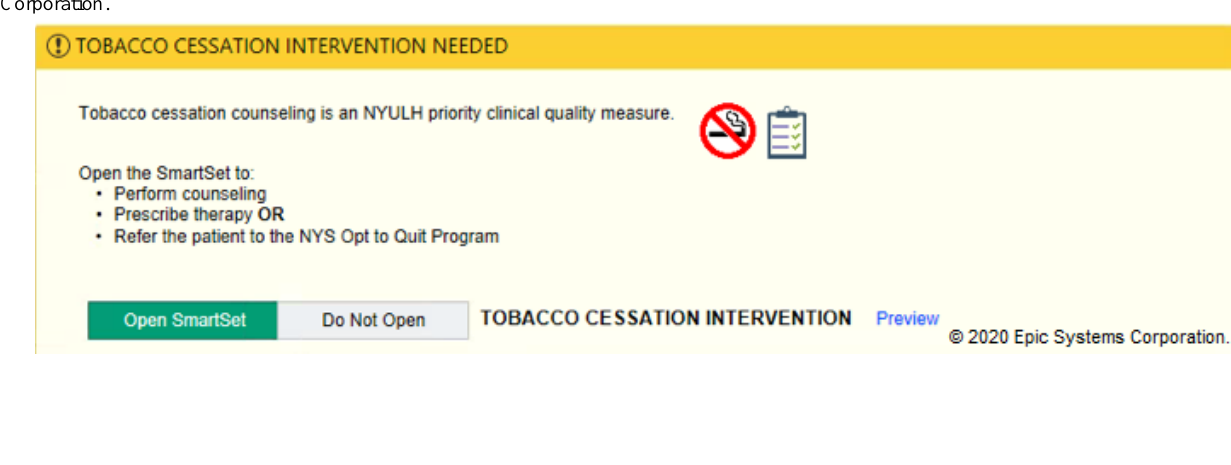
Figure 9. Tobacco regulatory messaging alert with images tested in Round 2 of the randomized controlled trial. Copyright 2020, Epic Systems